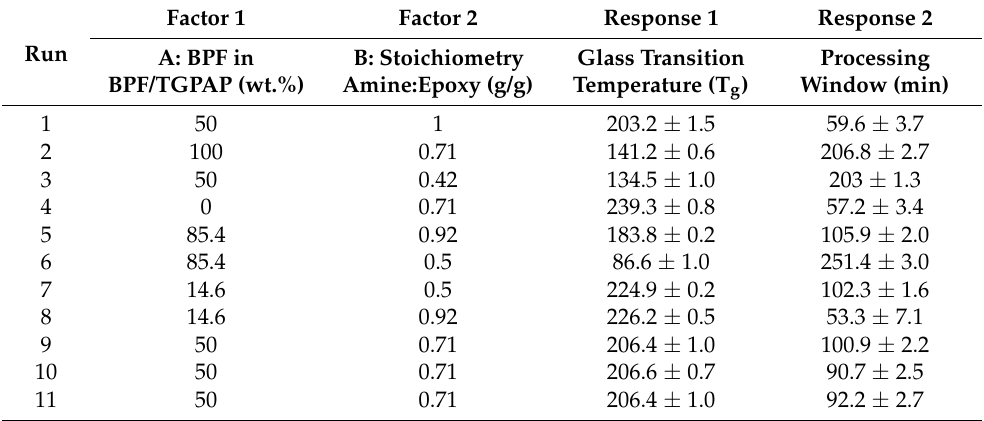
Figure 6. Actual values in the CCD. Table 2. Experimental results from the experimental design, n = 3. (Value of glass transition temperature was measured from the onset of the storage modulus curve).